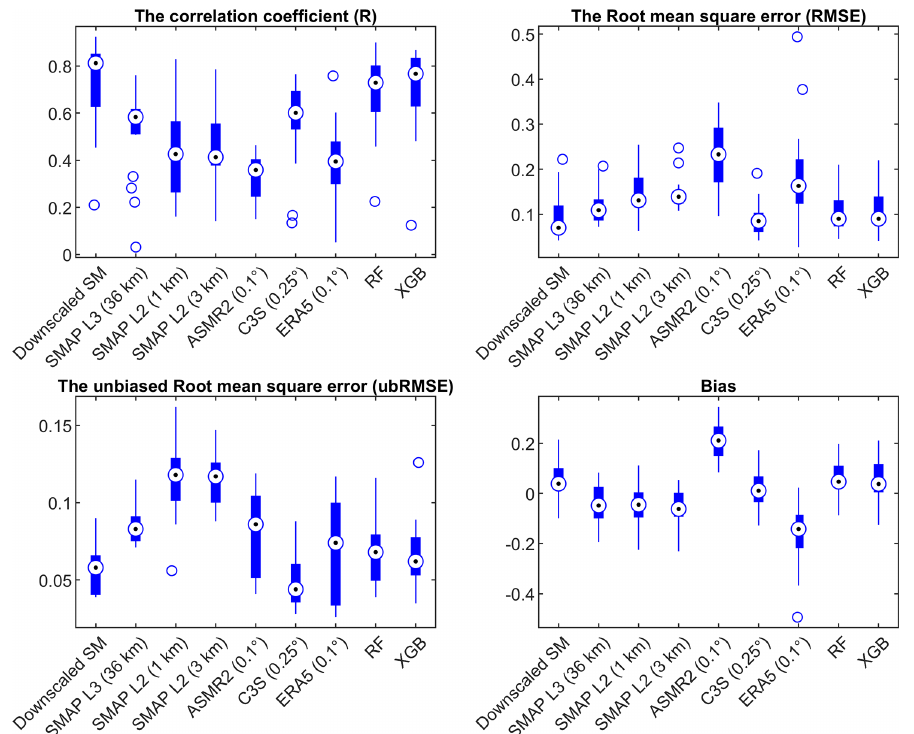
Figure 8. Comparison of gridded products and in situ observation SM of the Maqu